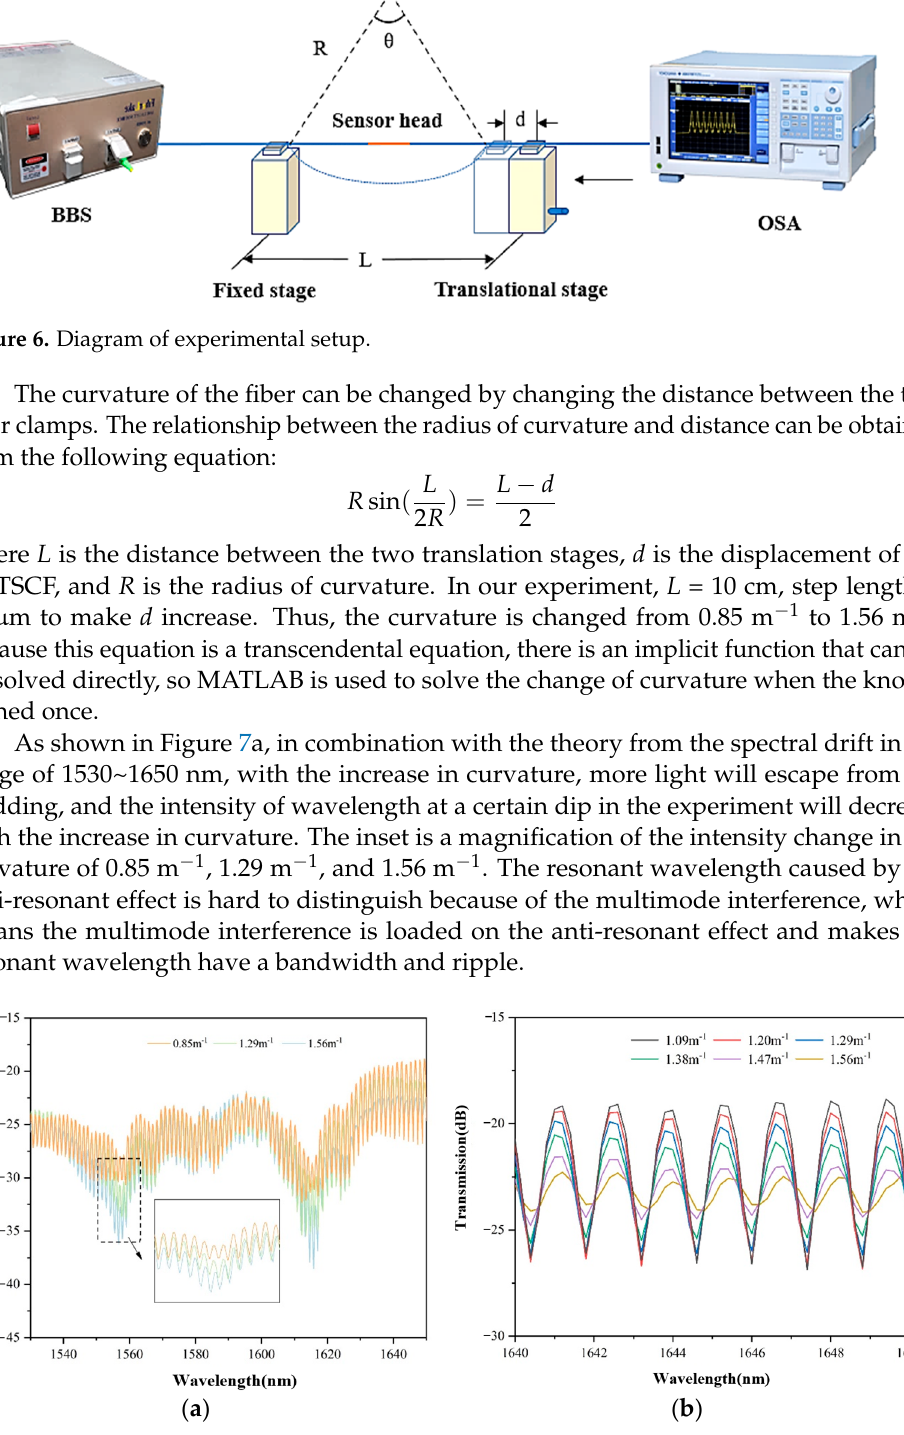
Figure 7. ( a ) Curvature response in the 1530~1650 nm spectral range; ( b ) Curvature response in the spectral range from 1640 to 1650 nm.